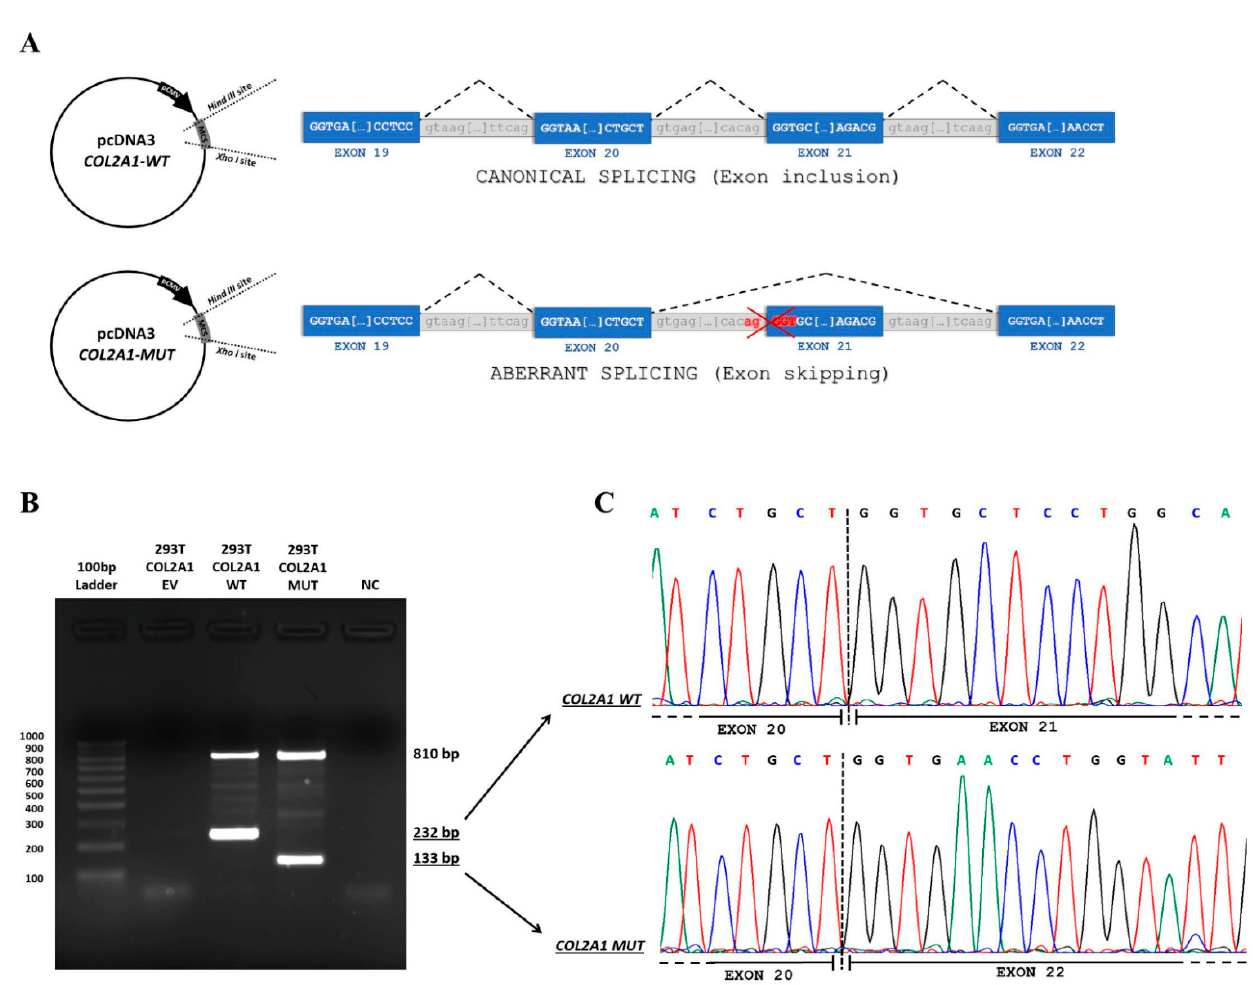
Figure 3. ( A ) Schematic representation of minigene construct. Exons 19, 20, 21, and 22 are represented, and expected spliced forms are indicated on the right side. Wild-type and mutated constructs are represented on the top and the bottom, respectively. ( B ) Electrophoresis of PCR amplification of nucleic acids extracted from HEK293T-transfected cells. RNA samples were reverse-transcribed and subjected to PCR amplification with specific primers located in exons 20 (Forward) and 23 (Reverse) of COL2A1 . The DNA band of 810 bp represents the non-spliced DNA of the transfected constructs, while the 232 and 133 bp bands represent the spliced transcripts in the cells transfected with the wild-type and mutated constructs. DNA was purified from the 232 and 133 bp bands and then sequenced (EV: Empty vector; WT: Wild-type minigene construct; MUT: Mutated minigene construct; and NC: Negative control). ( C ) Electropherograms of amplified products (wild-type and mutated) are shown in panel B.